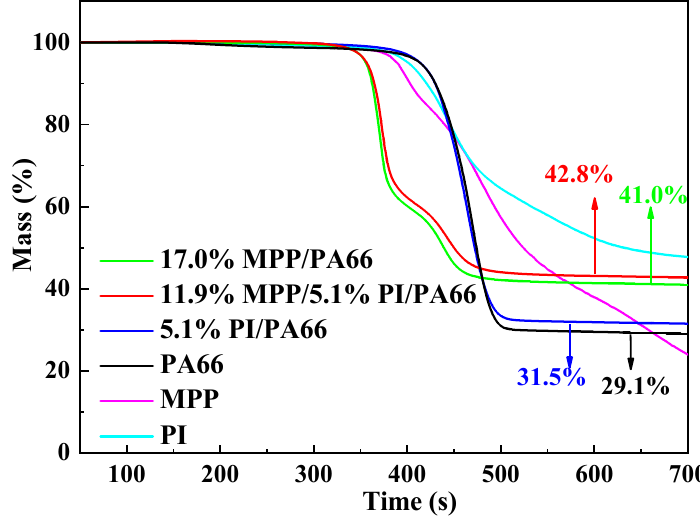
Figure 5. The TGA curves of the PA66 composites and flame-retardants.